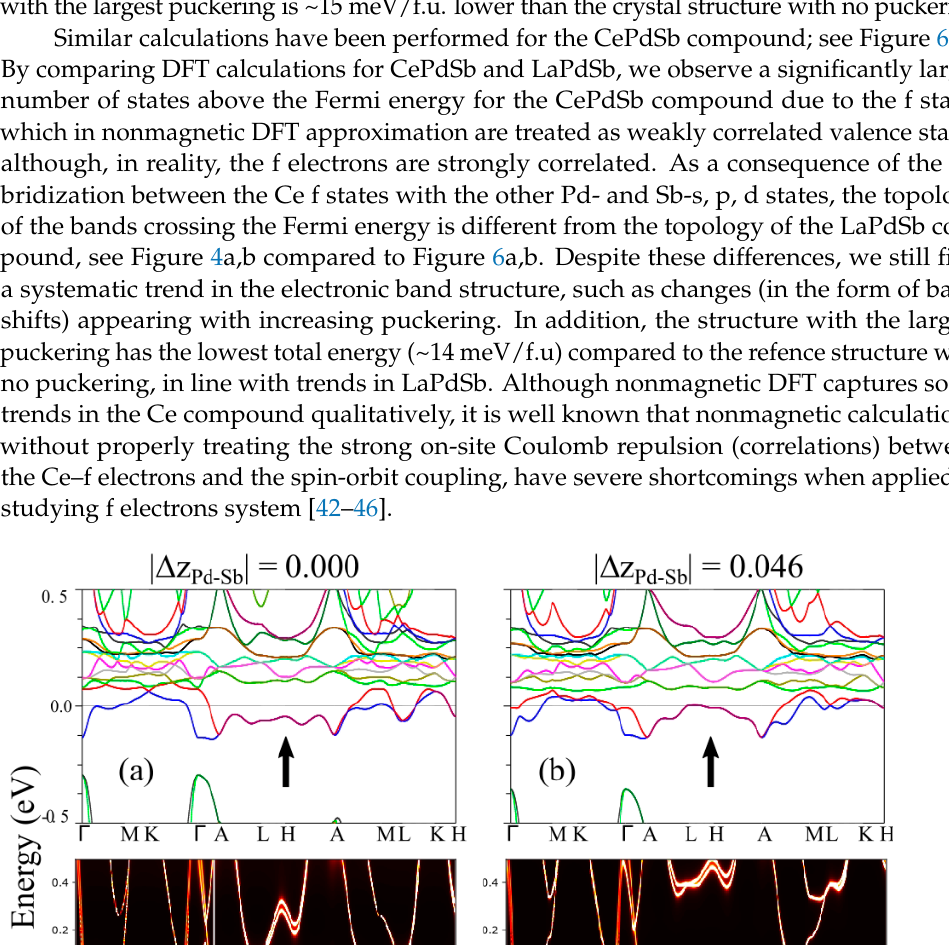
Figure 7. DFT+eDMFT spectral function and density of states for CePdSb: Spectral function with the − 5.5 to 5.5 eV, panel ( a ) and density of states panel ( b ); the inset in panel ( b ) shows the density of states for the Ce–f states below the Fermi energy and the arrows points toward a two peaks structure in the density of states. 5. Discussion Neutron and X-ray diffraction techniques have been used to study the crystal struc- tures and diffuse scattering in LaPdSb and CePdSb intermetallic compounds. These ex- perimental techniques were complemented by first-principles techniques such as DFT and DFT+eDMFT. Based on our study, we find that (I) LaPdSb and CePdSb compounds are best described by the hexagonal ZrBeSi-type structure (with the non-centrosymmetric space group P6 3 mc) where Pd and Sb ions order within puckered layers while no